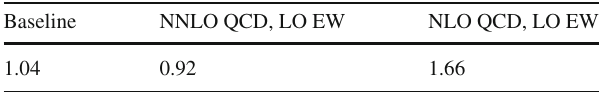
Table 5 χ 2 / N pts for the ATLAS 8 TeV differential top data, with α S free, in the lepton+jet channel. Results using different choices of theory for the matrix element calculation are shown